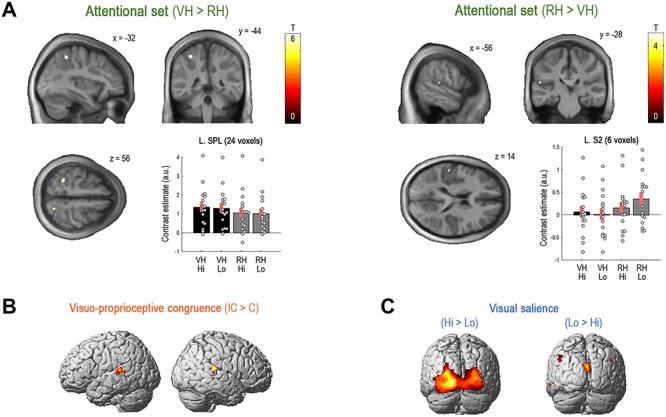
 Significant brain activation differences. (A) Main effects of attentional set. During the VH > RH task, we observed significantly increased responses in the bilateral SPL; at uncorrected thresholds, further activation differences were observed in the left V5 and V1 (Supplementary Figs 5 and 6). Conversely, during the RH > VH task, there were significantly increased responses in the left S2. The plots show the contrast estimates for each condition with associated standard errors; the individual participants’ contrast estimates are shown as gray dots. VH/RH = virtual hand/real hand task; Lo/Hi = low/high visibility. (B) Visuo-proprioceptive incongruence > congruence increased responses in bilateral temporal regions and the left S2. (C) Visual salience (high > low) increased responses in primary and extrastriate visual regions. All SPMs and renders are thresholded at P < 0.05, FWE corrected for multiple comparisons. The corresponding unthresholded statistical maps can be viewed at https://neurovault.org/collections/4868/. See Table 1 for details.